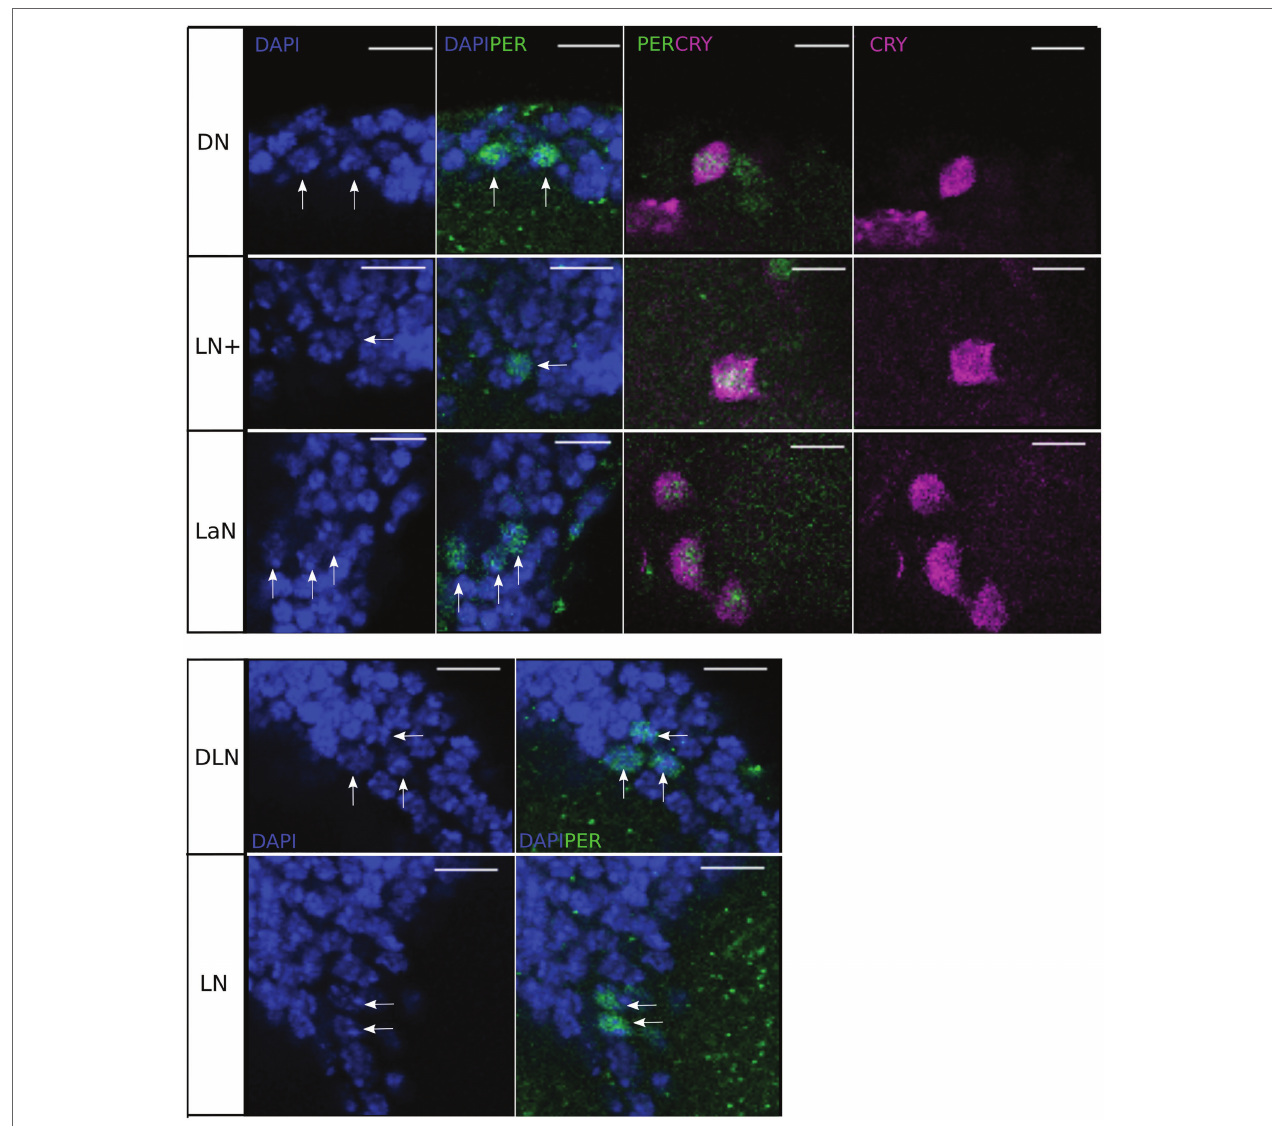
FIGURE 5 | Single stacks of co-immunostainings with anti-PER, anti-CRY, and DAPI at ZT21. DAPI and anti-PER co-localize in the nuclei of all clock neurons. Moreover, in the clusters co-localizing anti-CRY and anti-PER (DN, LN+, and LN), anti-PER is nuclear while anti-CRY is mainly cytoplasmic. Scale-bar: 10 μ